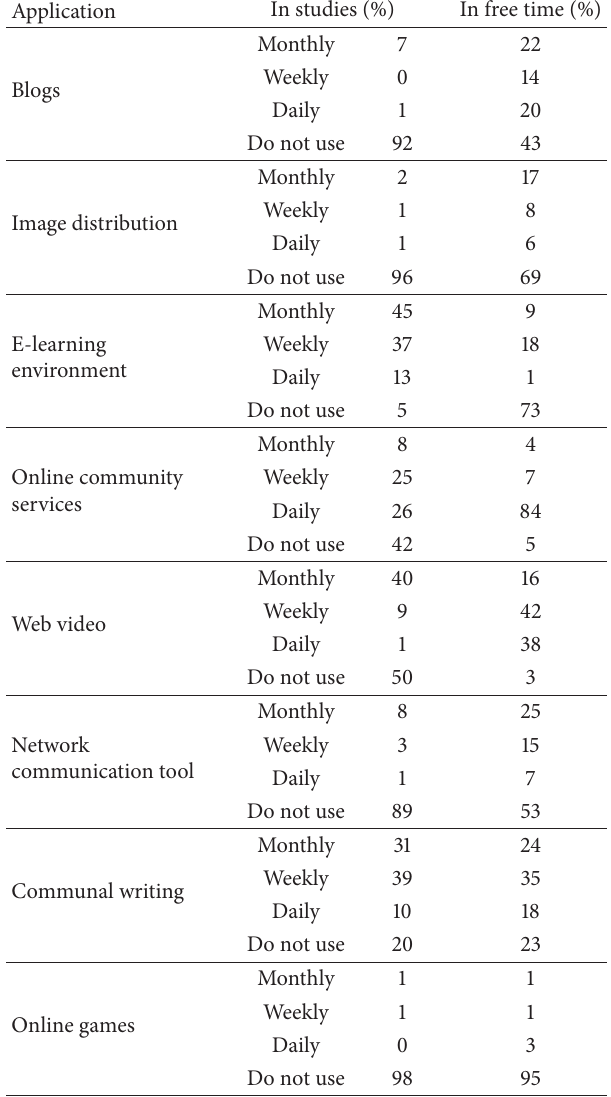
Table 2: Social media applications in studies and in free time. Table 3: Summary of social media applications’ interest, impor- tance, and skill